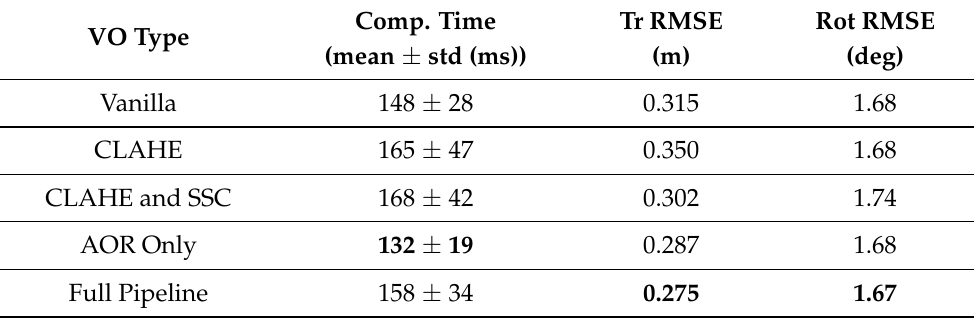
Table 7. Computation time comparison for summit XLS steel sequences.